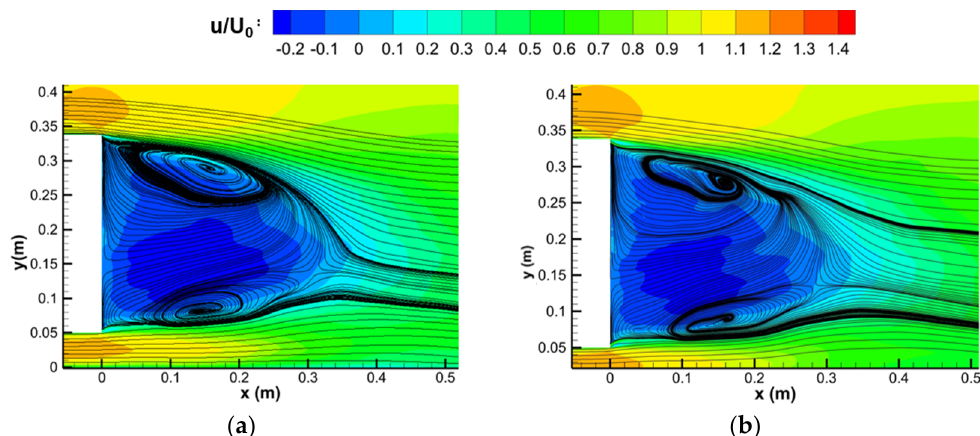
Figure 21. Time-averaged streamlines in the behind of the model, on the symmetry plane with a synthetic jet at different control frequencies. ( a ) f c = 68 Hz; ( b ) f c = 272 Hz.